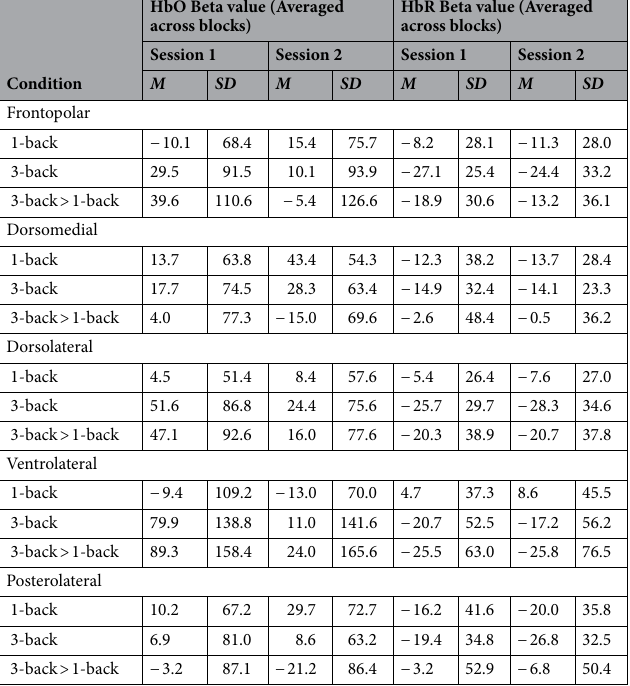
Table 4. Means and standard deviations of changes in oxyhemoglobin (HbO) and deoxyhemoglobin (HbR)